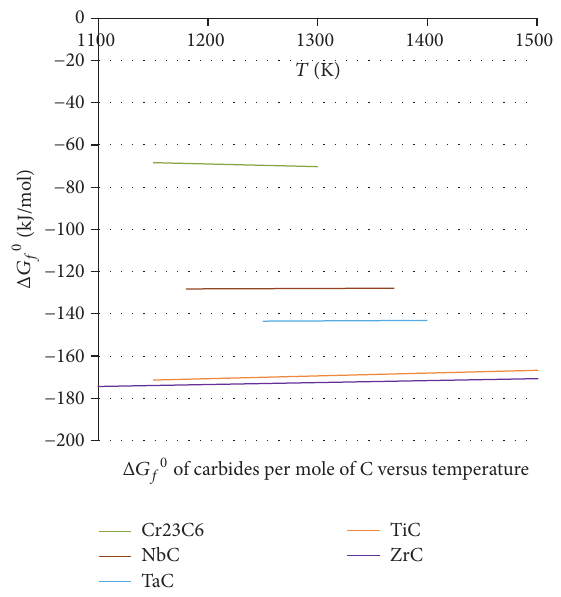
Figure 1: Gibbs enthalpies of formation of different carbides versus temperature (relative stabilities).